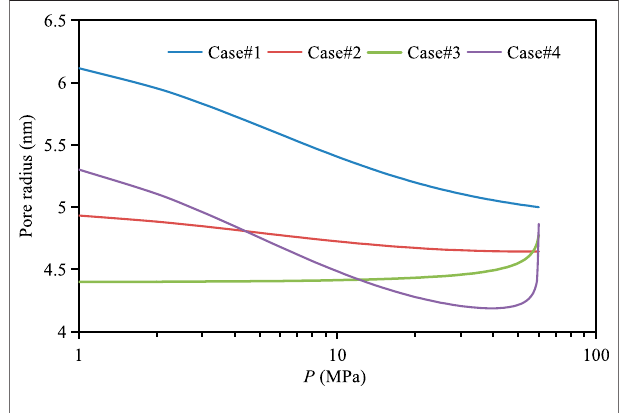
FIGURE 7 | Effects of different mechanisms on pore radius in organic pores.